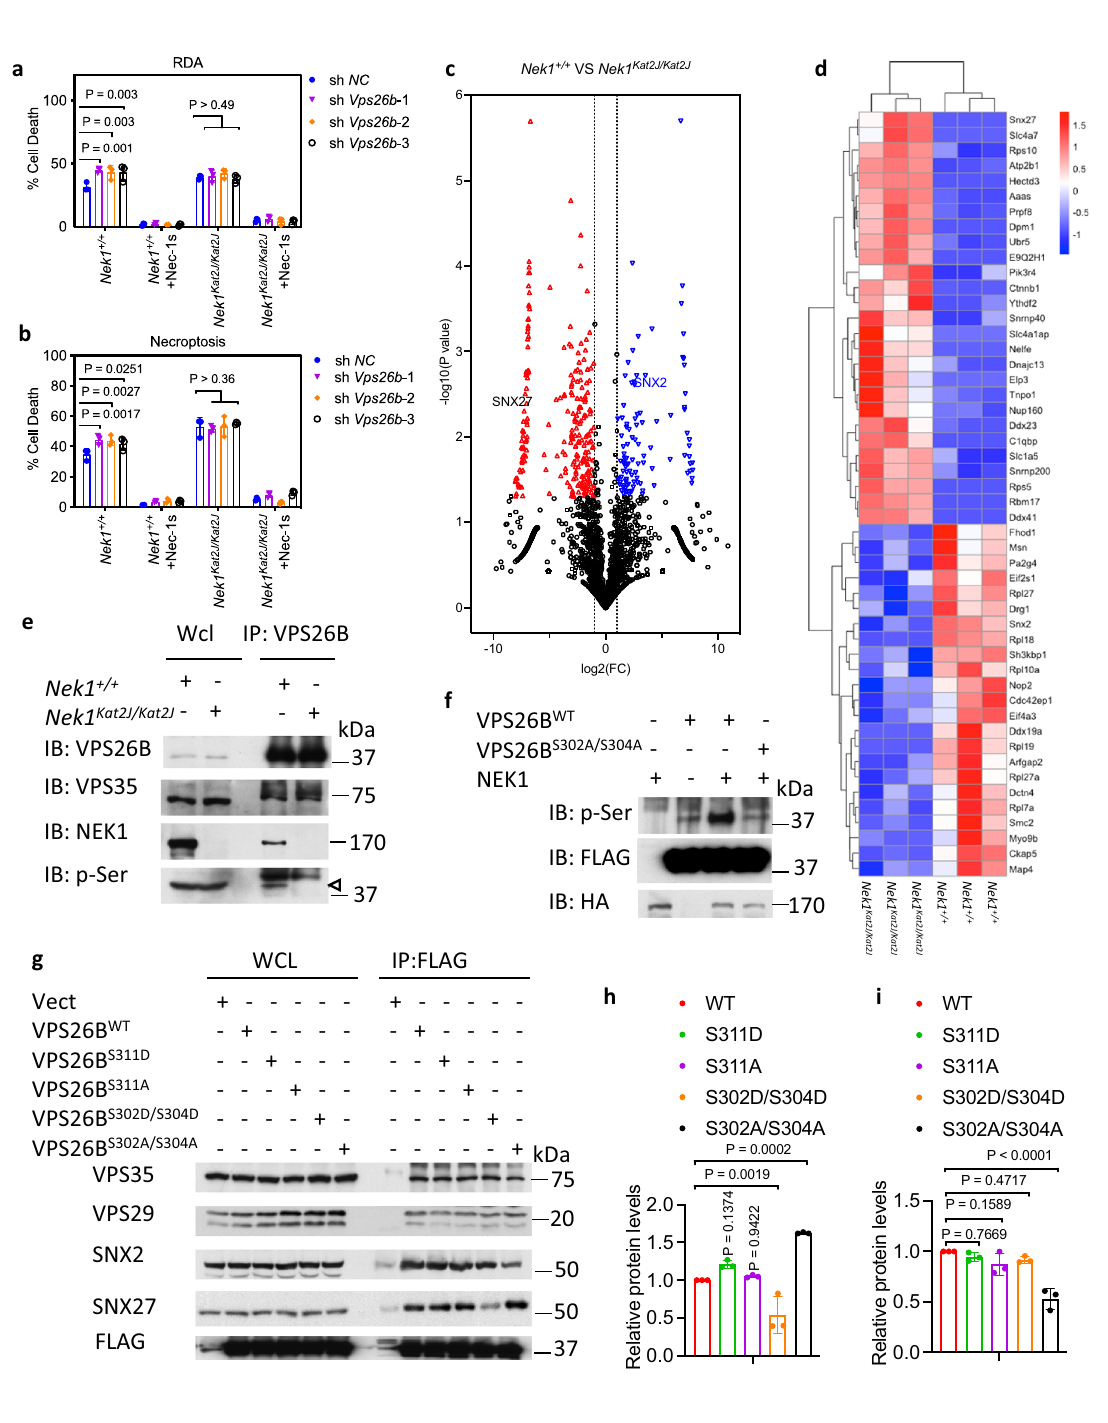
Fig. 3 Nek1 de fi ciency disrupts proteome homeostasis in the CNS. a , b Cerebral cortical sections from mice (3 weeks old) with indicated genotypes were stained with Thio fl avin S for protein aggregates and quanti fi ed ( b ). Mean±SD. n = 4 sections. One-way ANOVA with Dunnett ’ s test. Bar = 50 µ m. c , d Cerebral cortical sections of mice (3 weeks old) with indicated genotypes were immunostained with anti- α -synuclein(red) and anti-NeuN(green); and the fl uorescent intensity of α -synuclein in each NeuN positive cells was quanti fi ed ( d ). Bar = 50 µ m. n = 3 sections per group. Data are presented as mean±SEM. One-way ANOVA with Dunnett ’ s test. e Total cortical lysates from Nek1 + / + mice, Nek1 Kat2J/Kat2J mice, Nek1 + / + ; Ripk1 D138N/D138N mice and Nek1 Kat2J/Kat2J ; Ripk1 D138N/D138N mice were analyzed by western blotting with indicated antibodies. Uncropped blots in the Source Data fi le. f , g The mRNAs from spinal cords ( f ) or brains ( g ) mice with indicated genotypes ( n = 3 per group, 3 weeks old) were extracted and quanti fi ed for the levels of indicated cytokines by qPCR. Data are presented as mean±SD. One-way ANOVA with Dunnett ’ s